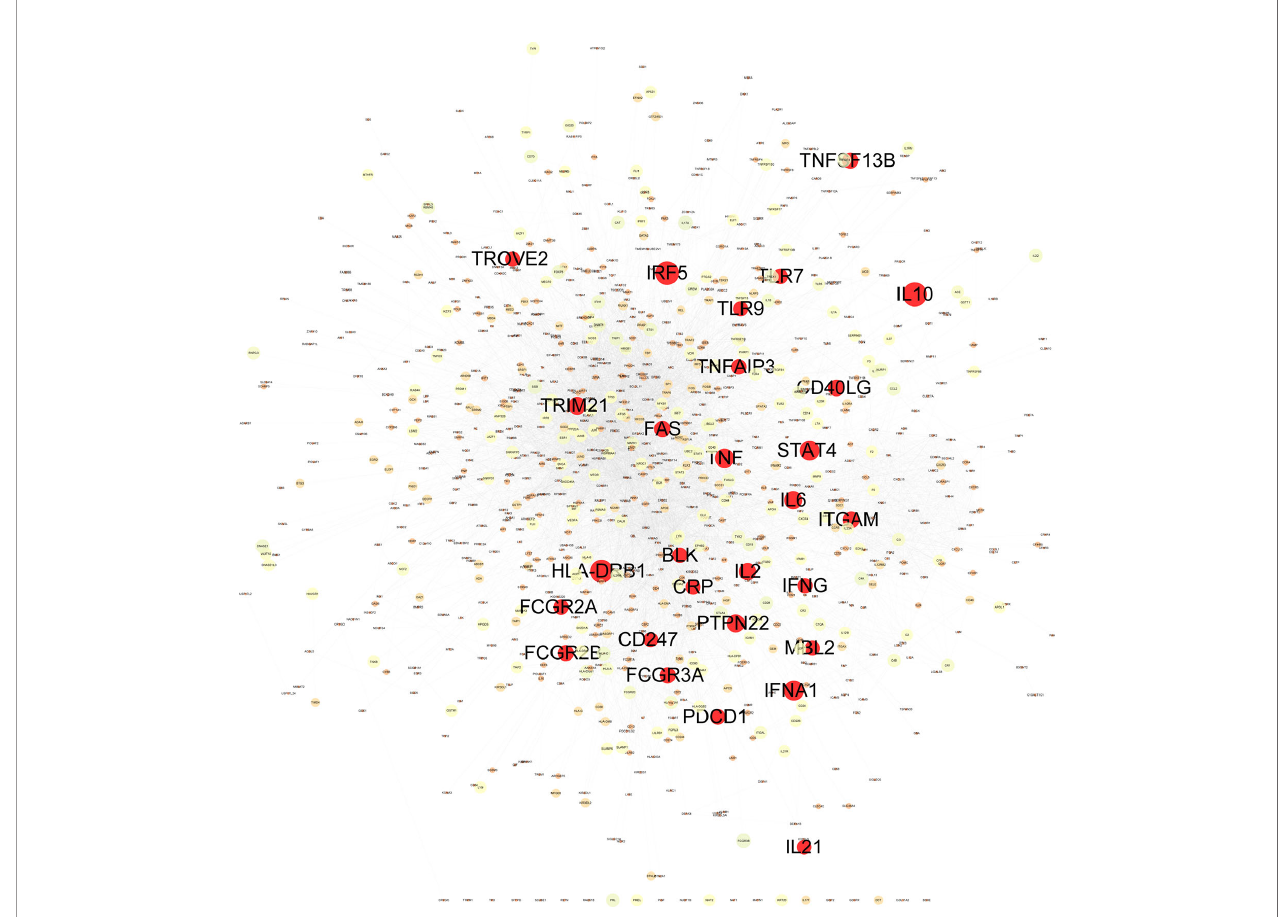
FIGURE 2 | Weighted gene regulatory network of SLE. The weighted gene regulatory network contains 950 nodes and 6,984 edges. The number of literature reports of one node represent the weight of the node. The red nodes list the top 30 of SLE pathogenetic genes in the weighted gene regulatory